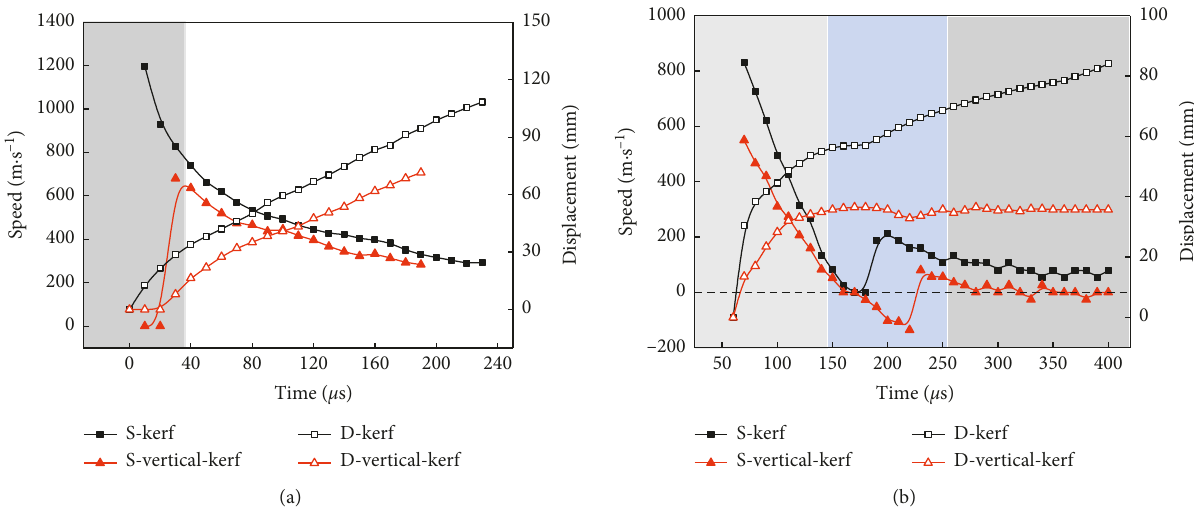
Figure 5: Curve of cutting seam cartridge explosion shock wave and explosion gas displacement—speed over time. (a) Explosive shock wave. (b) Detonation gas.